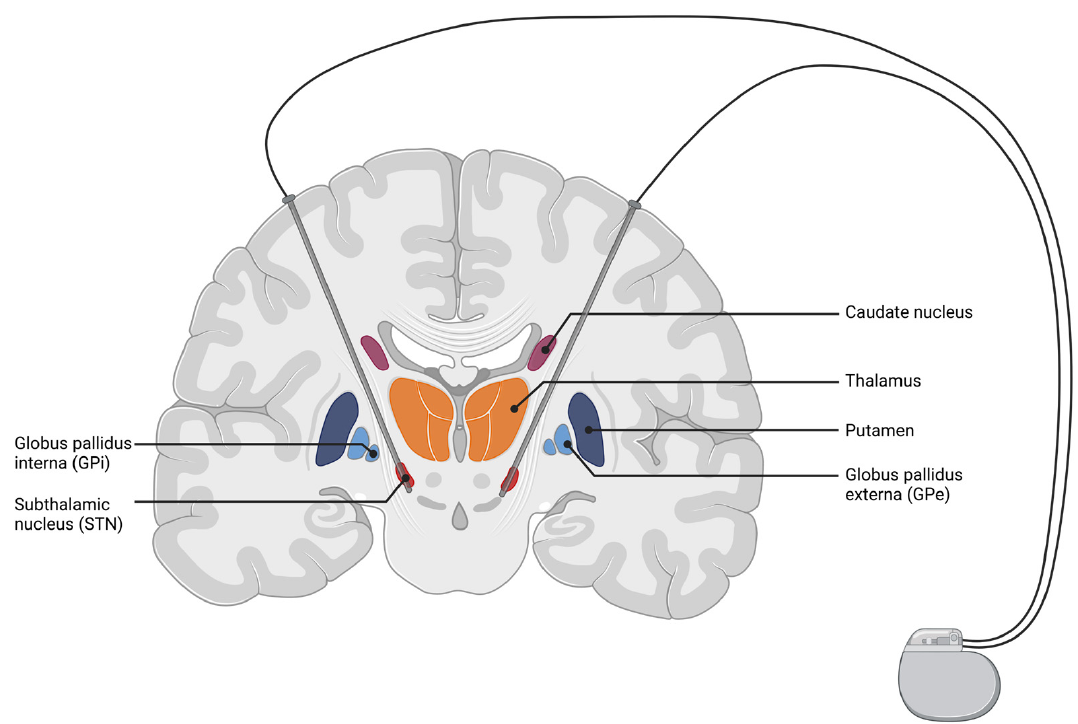
Figure 2. Coronal cut of the brain, highlighting structures of the basal ganglia (BG) with an exemplary depiction of a DBS setup targeting the subthalamic nucleus. Electrical current is delivered from the implanted pulse generator to the targeted brain structure. The figure was created with biorender.com (accessed 1 February 2022).